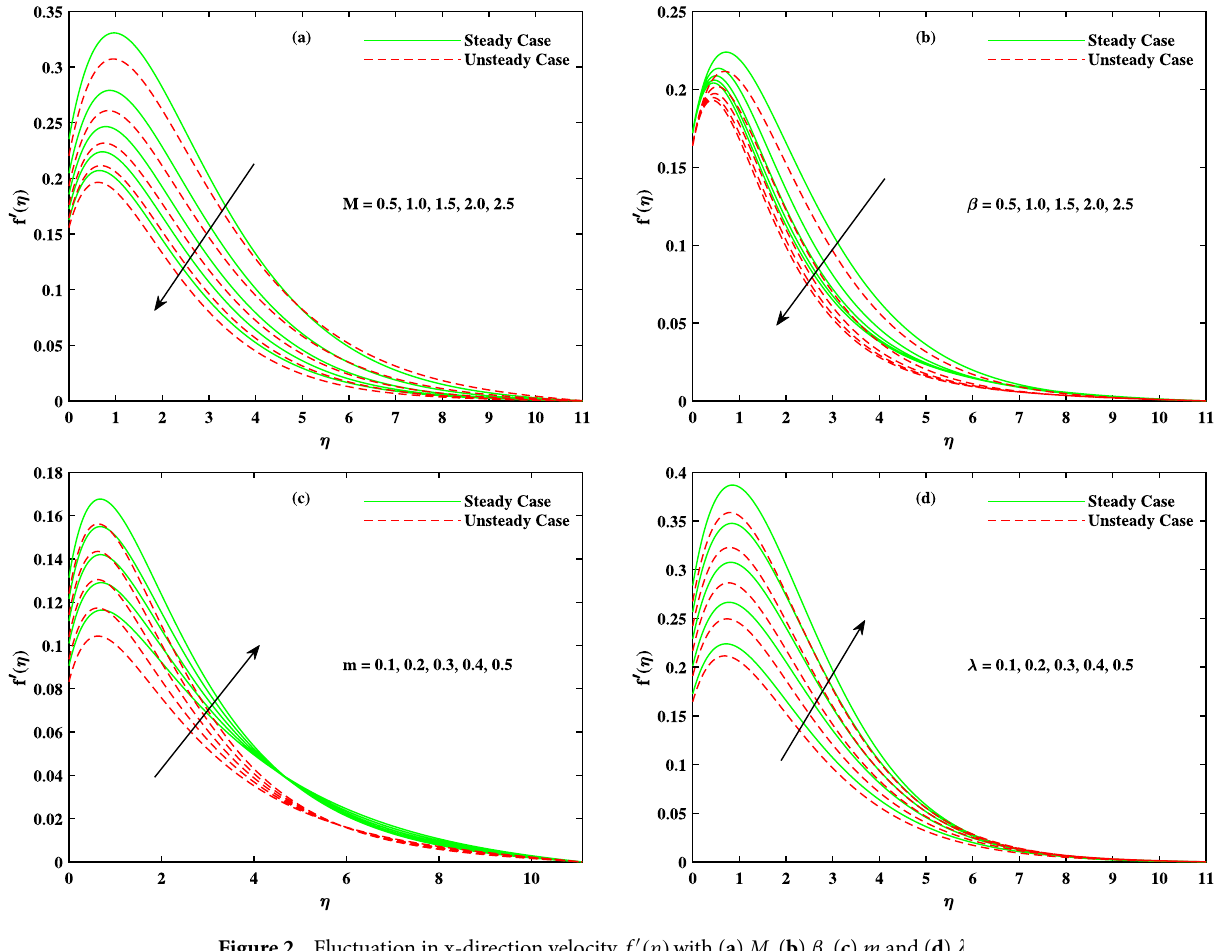
Figure 2. Fluctuation in x-direction velocity f ′ (η) with ( a ) M , ( b ) β , ( c ) m and ( d ) (cid:31)